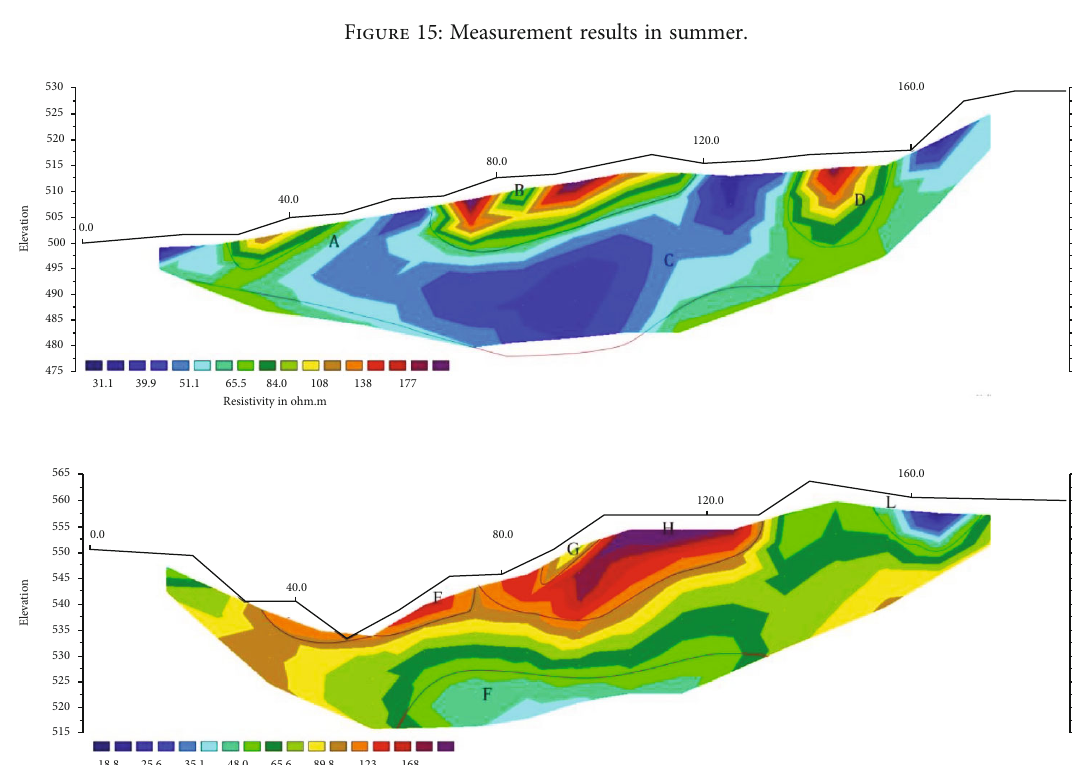
Figure 16: Measurement results in